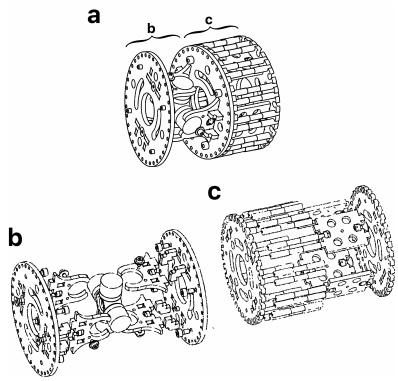
Figure 2. ( a ) Drawing of the base module. ( b ) Exploded view the static segment of the base module devised to increase the robot length. ( c ) Exploded view of the universal